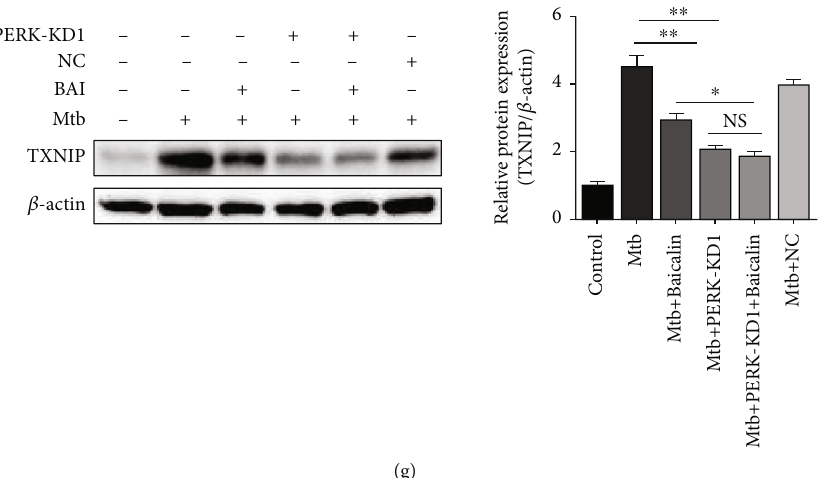
Figure 6: Baicalin reduces pyroptosis in Mtb-infected macrophages by inhibiting PERK/eIF2 α activation. (a, c) Western blotting analysis of GSDMD-N expression after IRE1 α siRNA in RAW264.7 cells. (b, d) Level of GSDMD-N protein was detected by western blotting after PERK siRNA in RAW264.7 cells. (e, f) Production of IL- β was assessed by ELISA measurement after IRE1 α or PERK siRNA, respectively, in RAW264.7 cells. (g) Level of TXNIP protein was analyzed by western blotting after PERK siRNA in RAW264.7 cells. Data are shown as mean ± SD of at least three independent experiments. ∗ p < 0 : 05 ; ∗∗ p < 0 : 01 ; NS: nonsigni fi